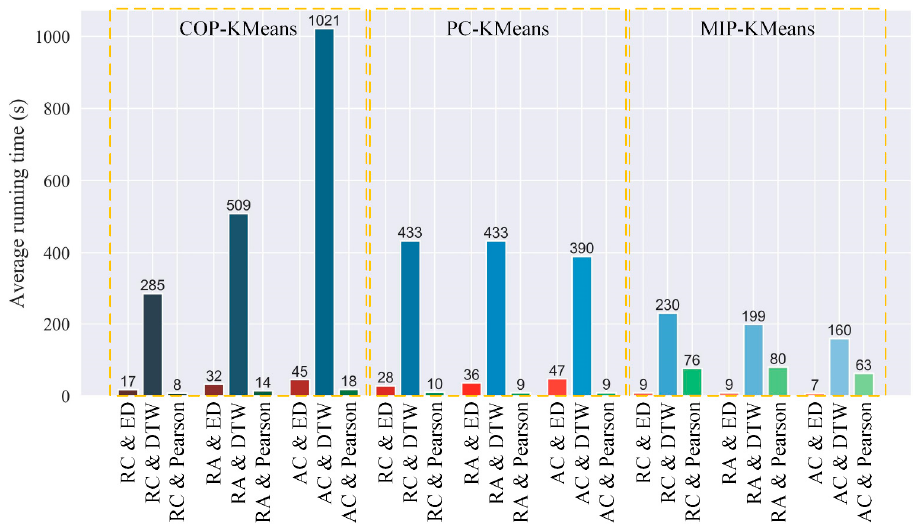
Figure 10. Average running time of each algorithm. The bars in the red range are the results using ED, the bars in the blue range are the results using DTW, and the bars in the green range are the results using Pearson.